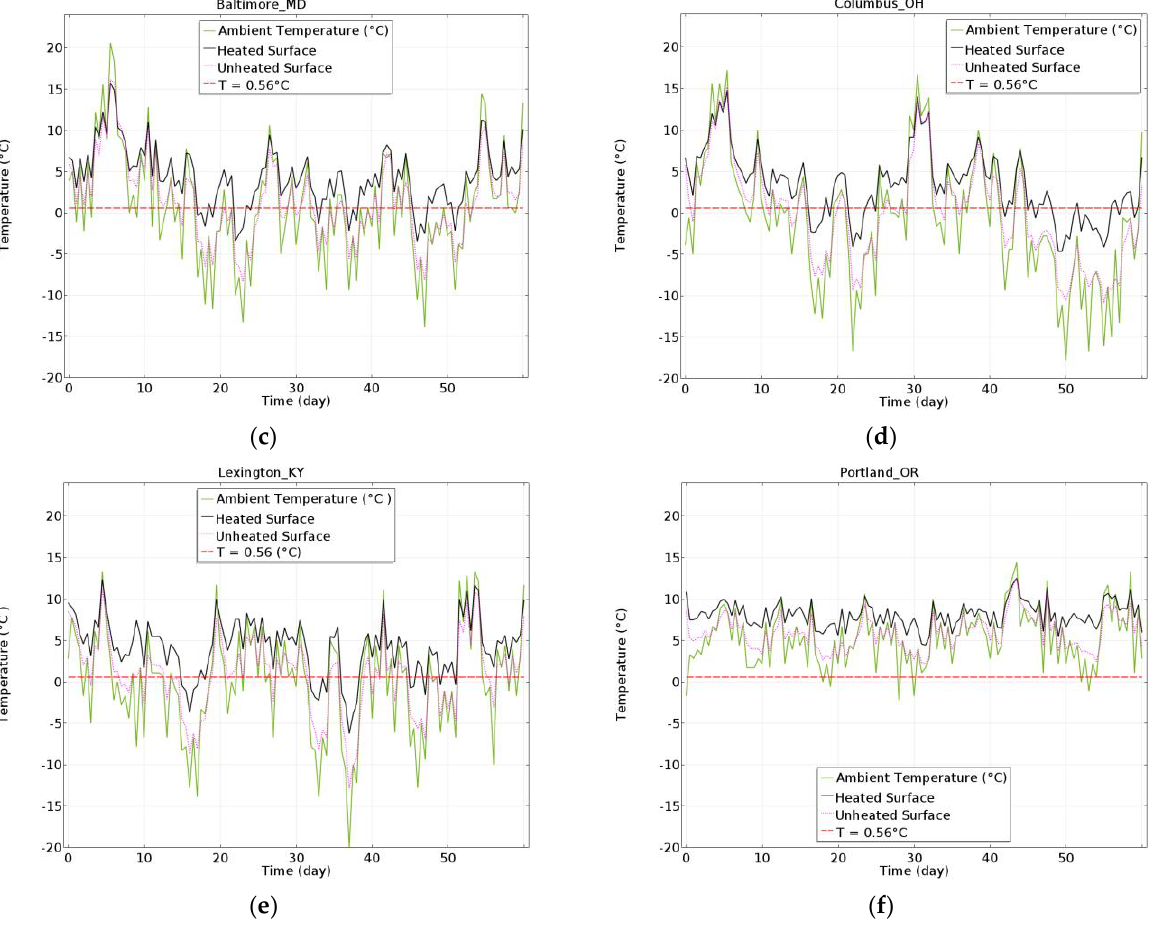
Figure 10. Pavement temperature for six various locations: (a) Albuquerque, NM; (b) Amarillo, TX; (c) Baltimore, MD; (d) Columbus, OH; (e) Lexington, KY; and (f) Portland, OR.